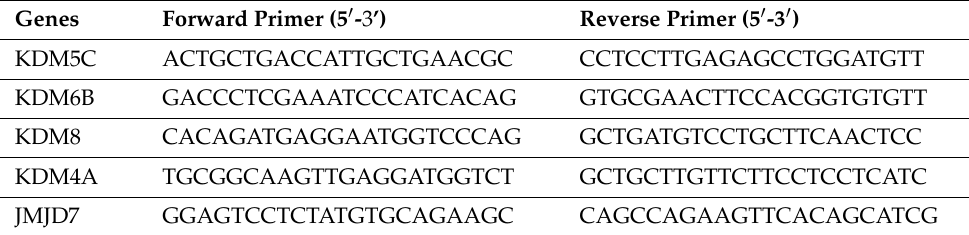
Table 1. Forward and reverse primer sequences of selected genes.